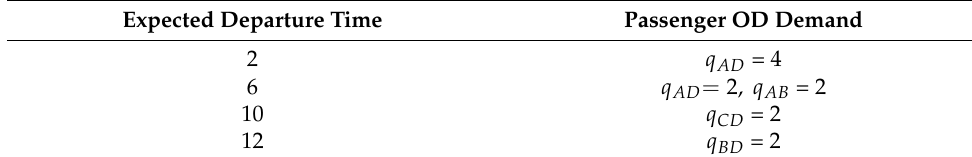
Table 2. Passenger OD demand with expected departure time.